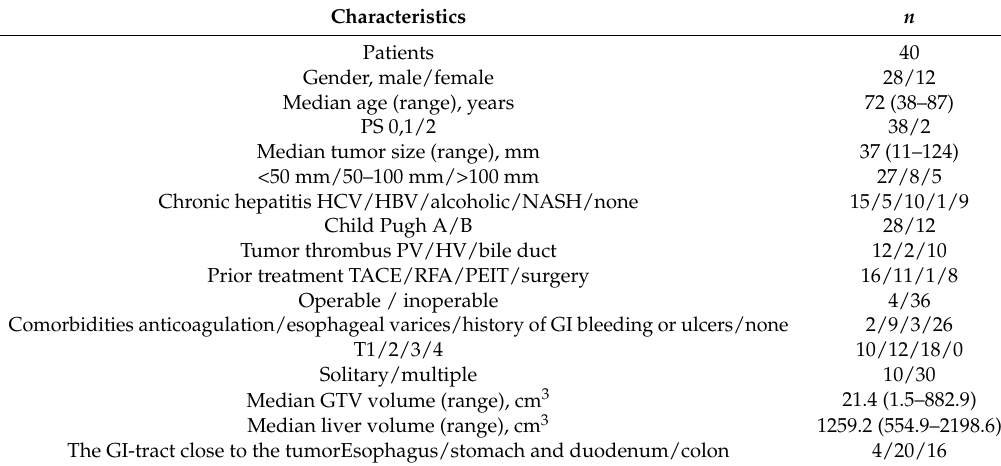
Table 1. Patient and tumor